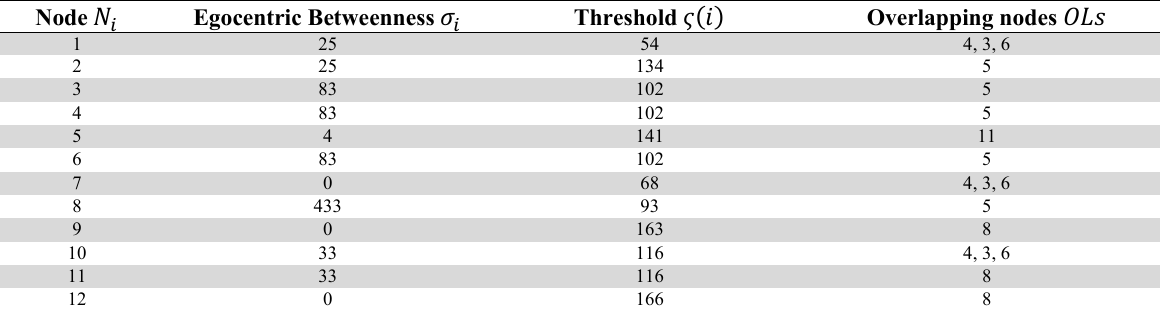
Algorithm 2. Overlapping node detection and summary vector based message pruning